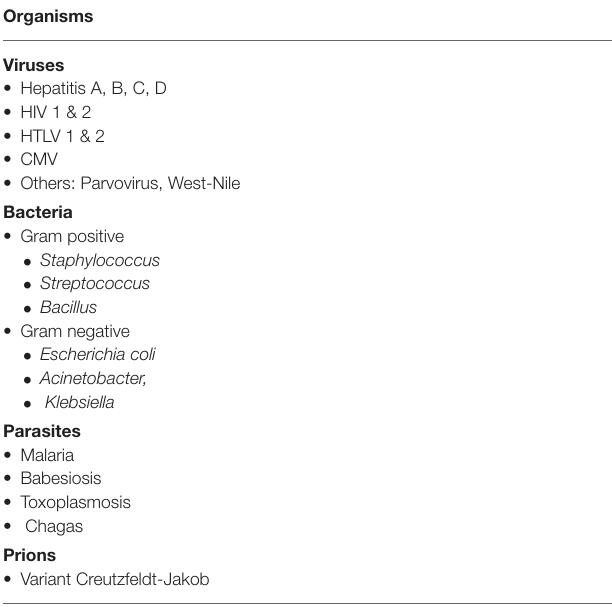
TABLE 1 | Common infections associated with transfusion. Organisms